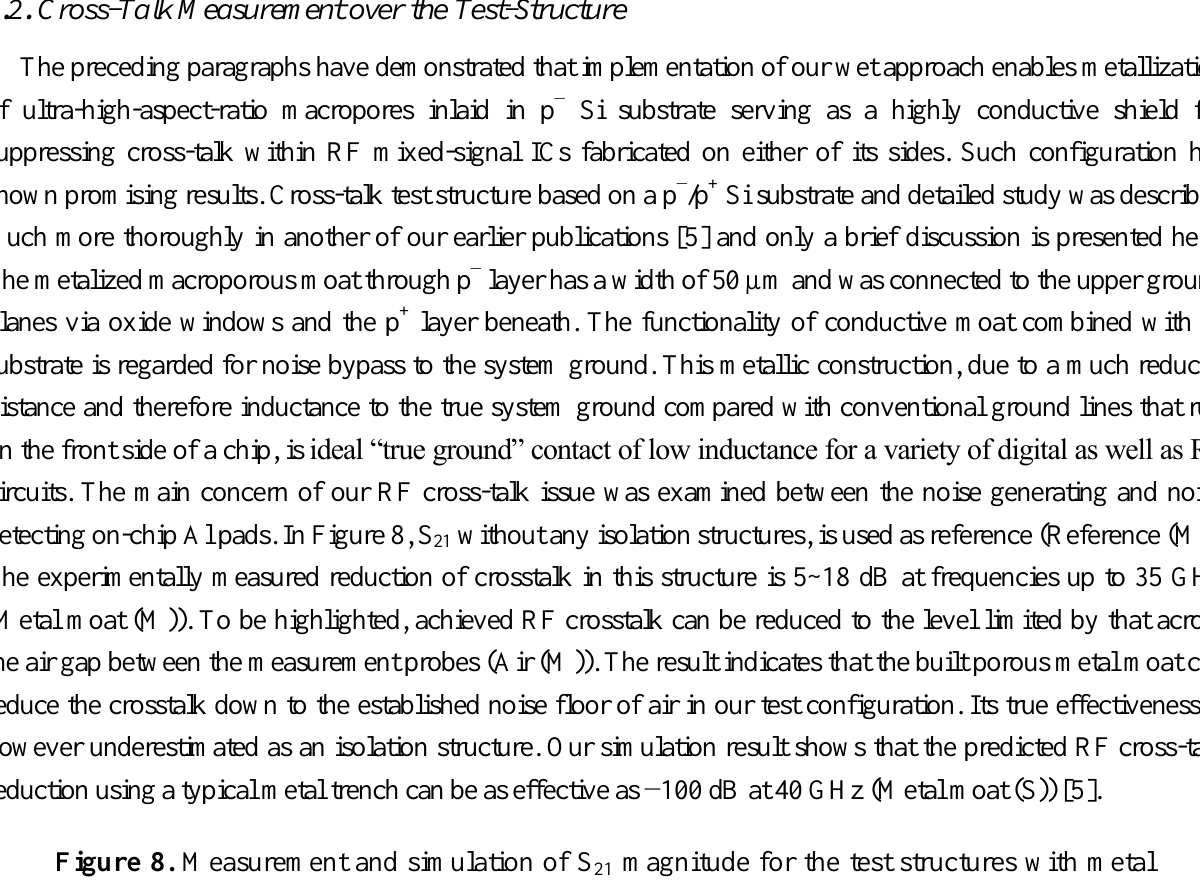
Figure 8. Measurement and simulation of S magnitude for the test structures with metal 21 via isolation: Reference indicates there is no isolation structure. Air crosstalk is measured by microprobes suspended in air at Al pad separation distance of 800 µm. (M) indicates measurement result and (S) indicates simulation